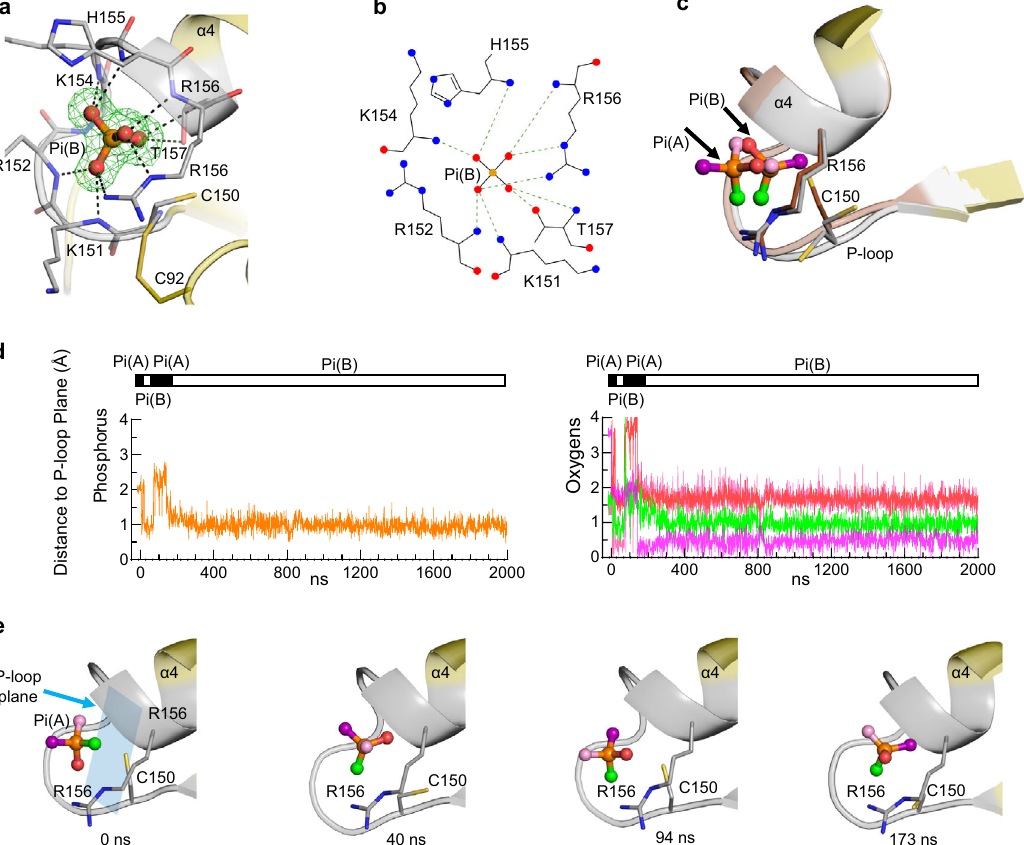
Fig. 5 Analysis of Pi mobility inside the catalytic center. a Pi(B), in stick and ball format (phosphorus is orange, oxygen is red), in a crystal structure complex with At PFA-DSP1 49 – 215 (PDB accession code 7MOL) obtained in the absence of mercaptoethanol (see text). Broken lines depict polar interactions of Pi(B) ( ≤ 3.2 Å) with nearby residues (nitrogens are blue). The Fo-Fc electron density map (green mesh) is contoured at 5 σ . b corresponding rendering of the ligand – protein interactions created by Ligplot + . c Pi(B) from panel ( a ) is superimposed upon Pi(A) (taken from Fig. 2a); the P-loops of the corresponding proteins are colored gray for Pi(B) and light brown/dark brown for Pi(A). Note the two conformations of Cys150, one of which may form a disul fi de bond (see panel a ). d , e the movement of the phosphorus atom is indicated by the orange trace, and each of the oxygen atoms of Pi(A) were arbitrarily colored either purple, light pink, red or green; this color scheme illustrates the predicted movements of each atom during molecular dynamics simulations, with reference to the plane of the backbone residues of the P-loop (blue rectangle; residues 151 – 156). Horizontal bars illustrate the switching between Pi poses A (black) and B (white). The coloration in this simulation has been transferred to Pi(B) in panels ( c ) and ( e ). Three additional replicates of the data in panel ( d ) are provided in Supplementary Fig. S8, and the initial 1000 ns of each of these aspects of all four simulations are animated in Supplementary Movies 1, 2, 3 and 4. Source data are provided as a Source Data fi